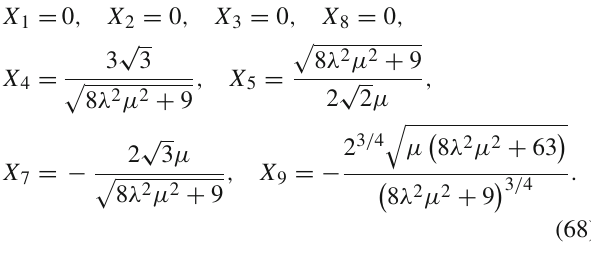
Fig. 8 The figure illustrates the relation between density parameter of non-vanishing fields and free parameters, i.e., λ and μ , for F point. Noted that the green, black, purple, blue and red line in the graph indicates (cid:12) A , (cid:12) φ , (cid:12) η